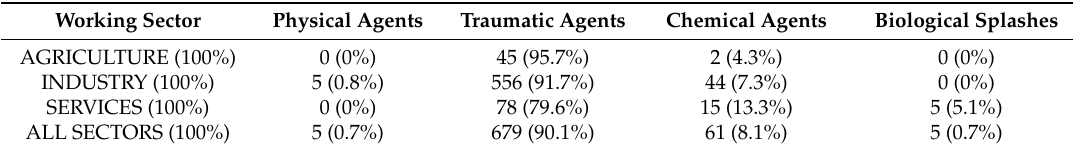
Table 2. The number of occupational eye-injuries sustained in 2014 in the province of Modena in agriculture, industry, and services, classified according to the causal agent involved (within brackets the percent values are reported).